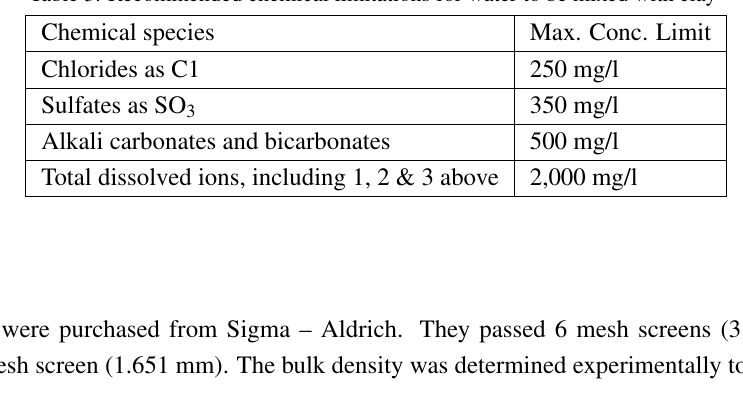
Table 3. Recommended chemical limitations for water to be mixed with clay